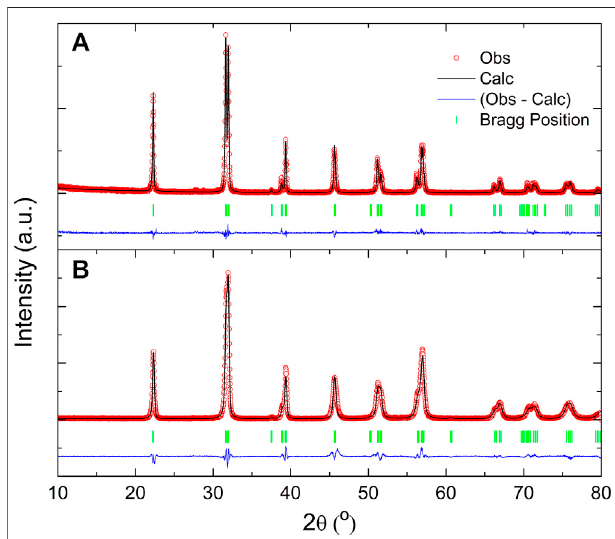
FIGURE 2 | The re fi ned XRD patterns of (A) BiFeO 3 synthesized by the ceramic method and (B) BiFeO 3 prepared by the combined mechanochemical − thermal route.